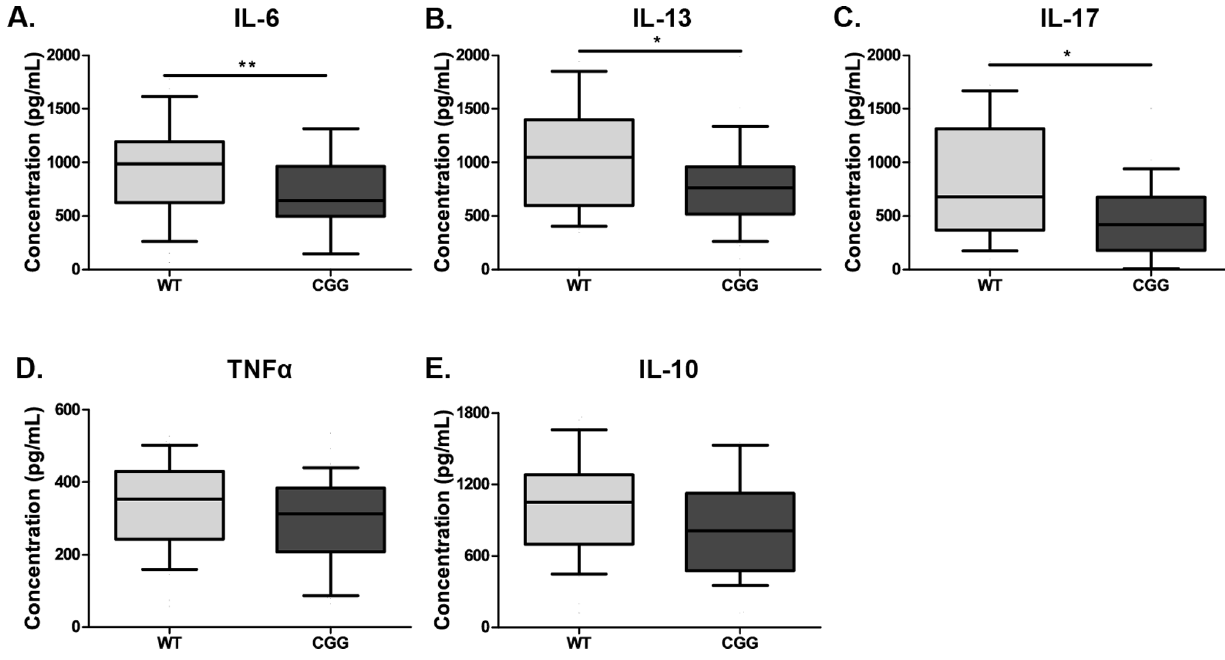
Figure 4. Cytokine production in mouse splenocytes. Splenocytes from CGG KI mice display significantly decreased production of ( A ) IL-6, ( B ) IL-13, and (C) IL-17 in responses to PMA/Ionomycin. There was a trend for decreased production of (D) TNF a , and (E) IL-10. *p , 0.05, and **p ,